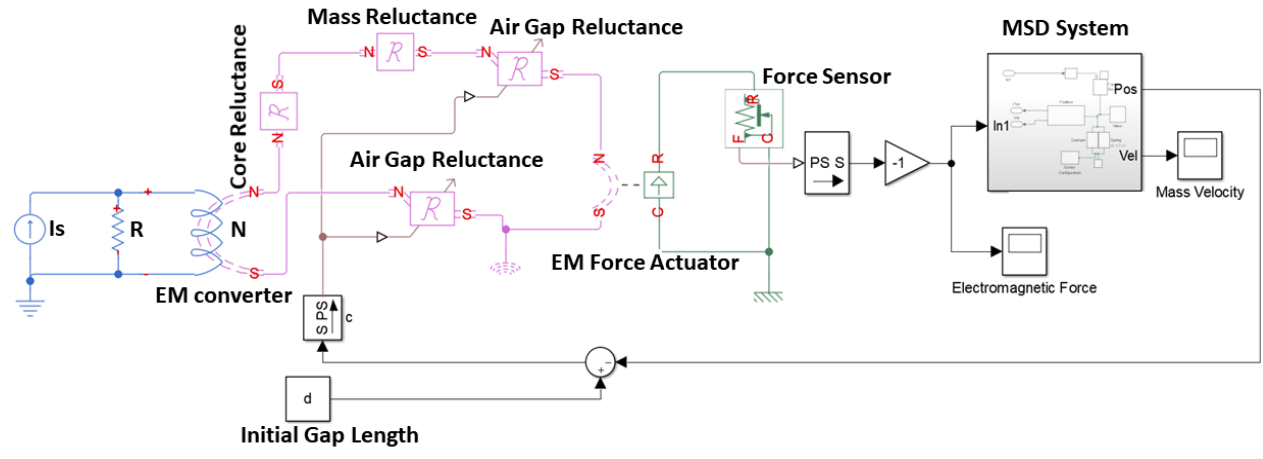
Figure 3. Simulink Simscape implementation of the electromechanical oscillator using the analytical expressions.